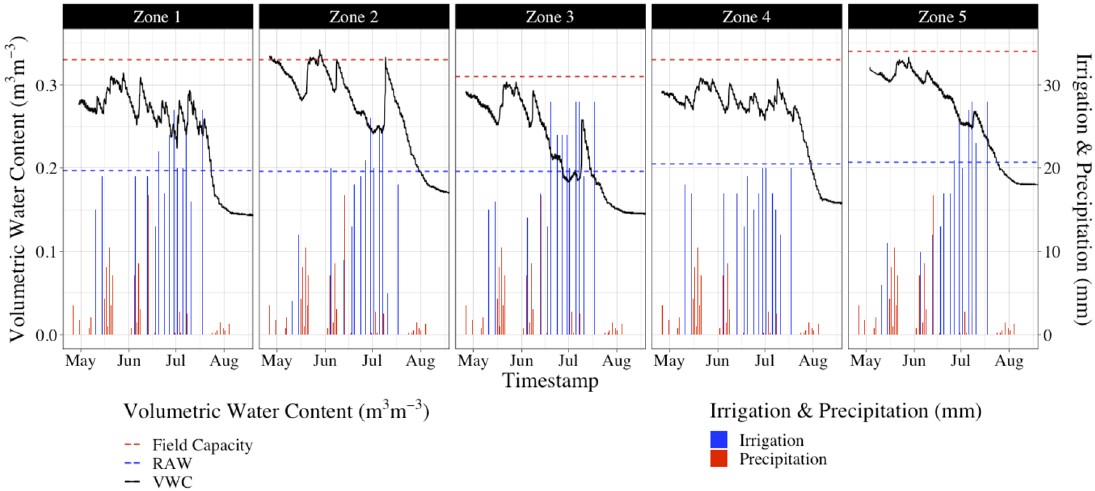
Figure 3. Temporal change in volumetric water content (VWC) at a depth of 0.0–0.3 m for a wheat crop in 2019 under variable rate irrigation (VRI) with five irrigation zones. Precipitation and zone- specific VRI events are also shown. Zone average field capacity (FC) and readily available water (RAW) are identified with blue and red lines,